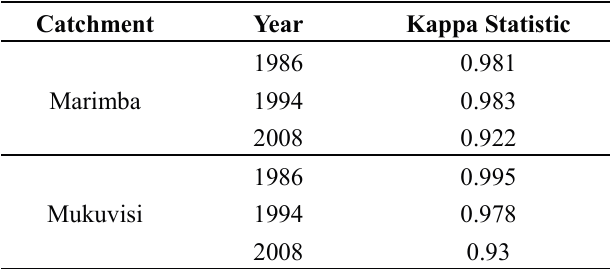
Table 8. Kappa statistics for the classified images of the Marimba and Mukuvisi catchments for 1986, 1994 and